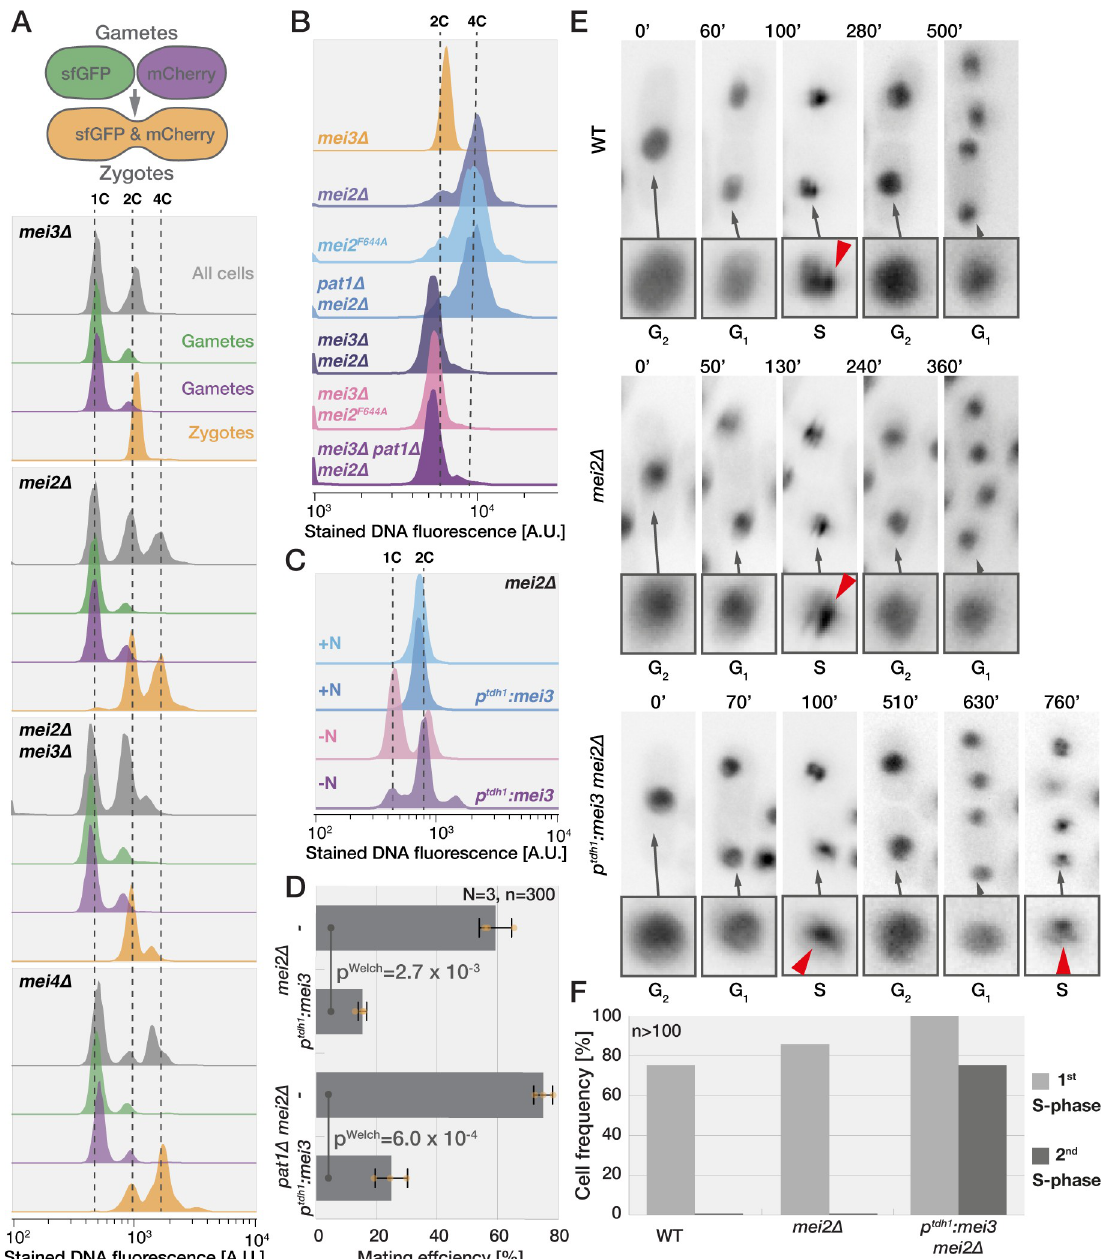
Fig 3. Mei3 promotes G1 exit independently of Pat1 and Mei2. (A) Strategy used for flow cytometry on mating mixtures of heterothallic strains that constitutively express either sfGFP or mCherry (top). Gametes, which carry a single fluorophore, can be distinguished from zygotes, which carry both fluorophores. Flow cytometry analysis of Hoechst-stained DNA fluorescence (x-axis) in mating mixtures after 24 hours (bottom). The y-axis shows the cell number normalized to mode. Profiles of all cells (gray), gametes (green and magenta), and zygotes (orange) are shown. Gametes largely arrest with unreplicated 1C genomes. mei3 Δ and mei3 Δ mei2 Δ zygotes show unreplicated 2C content. mei2 Δ and mei4 Δ zygotes show a prominent 4C peak. (B) Hoechst-stained DNA fluorescence in zygotes identified through gating for increased size in forward and side scatter measurements (see Materials and methods). Zygotes lacking mei3 arrest with unreplicated genomes (2C), while those with intact mei3 replicate their genomes even in absence of mei2 and pat1 . The smaller 2C peak in mei2 Δ zygotes compared to panel A likely stems from the gating strategy which excludes zygotes that have undergone mitotic division. (C) Hoechst-stained DNA fluorescence of haploid mei2 Δ cells with or without mei3 expressed from the constitutive p tdh1 promoter grown in presence or absence of nitrogen for 24 hours. Ectopic expression of Mei3 prevents the G 1 arrest in nitrogen starved gametes but has no effect in nitrogen-rich media. (D) Mating efficiency of mei2 Δ and mei2 Δ pat1 Δ cells with or without mei3 expressed from the constitutive p tdh1 promoter after 24-hour incubation on agar plates. Constitutive mei3 expression reduces mating of gametes independently of mei2